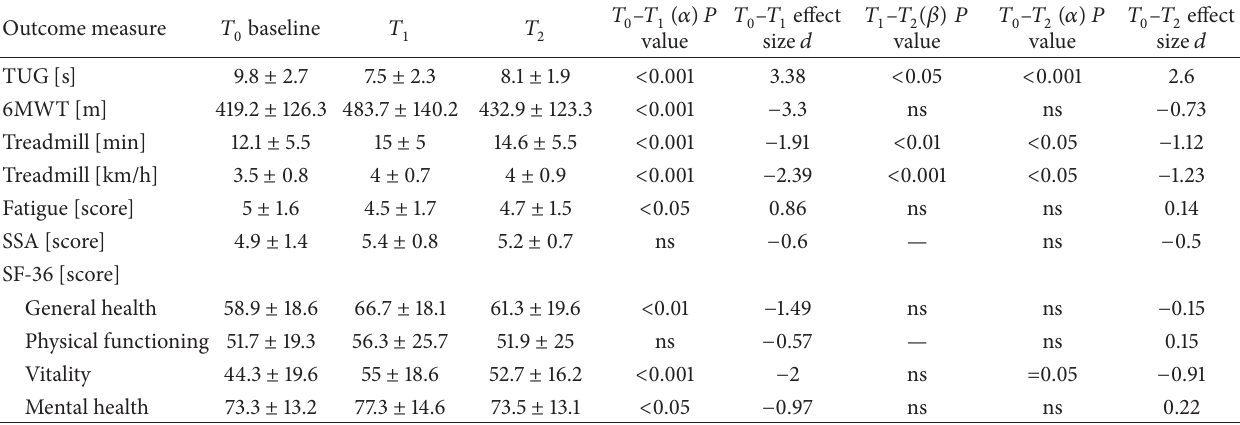
Table 5: M ± SD, reported for 𝑇 0 , 𝑇 1 , 𝑇 2 , within exercising group comparison from 𝑇 0 to 𝑇 1 using 𝑃 values and effect sizes ( 𝛼 , paired one- sided 𝑡 -test, 𝑃 ≤ 0.05); if significant 𝑃 value was reported from 𝑇 0 to 𝑇 1 , significance tests were calculated for 𝑇 1 minus 10% and 𝑇 2 ( 𝛽 , paired one-sided 𝑡 -test, 𝑃 ≤ 0.05); additionally, 𝑇 0 to 𝑇 2 comparisons were calculated using 𝑃 values and effect sizes ( 𝛼 , paired one-sided 𝑡 -test, 𝑃 ≤ 0.05).